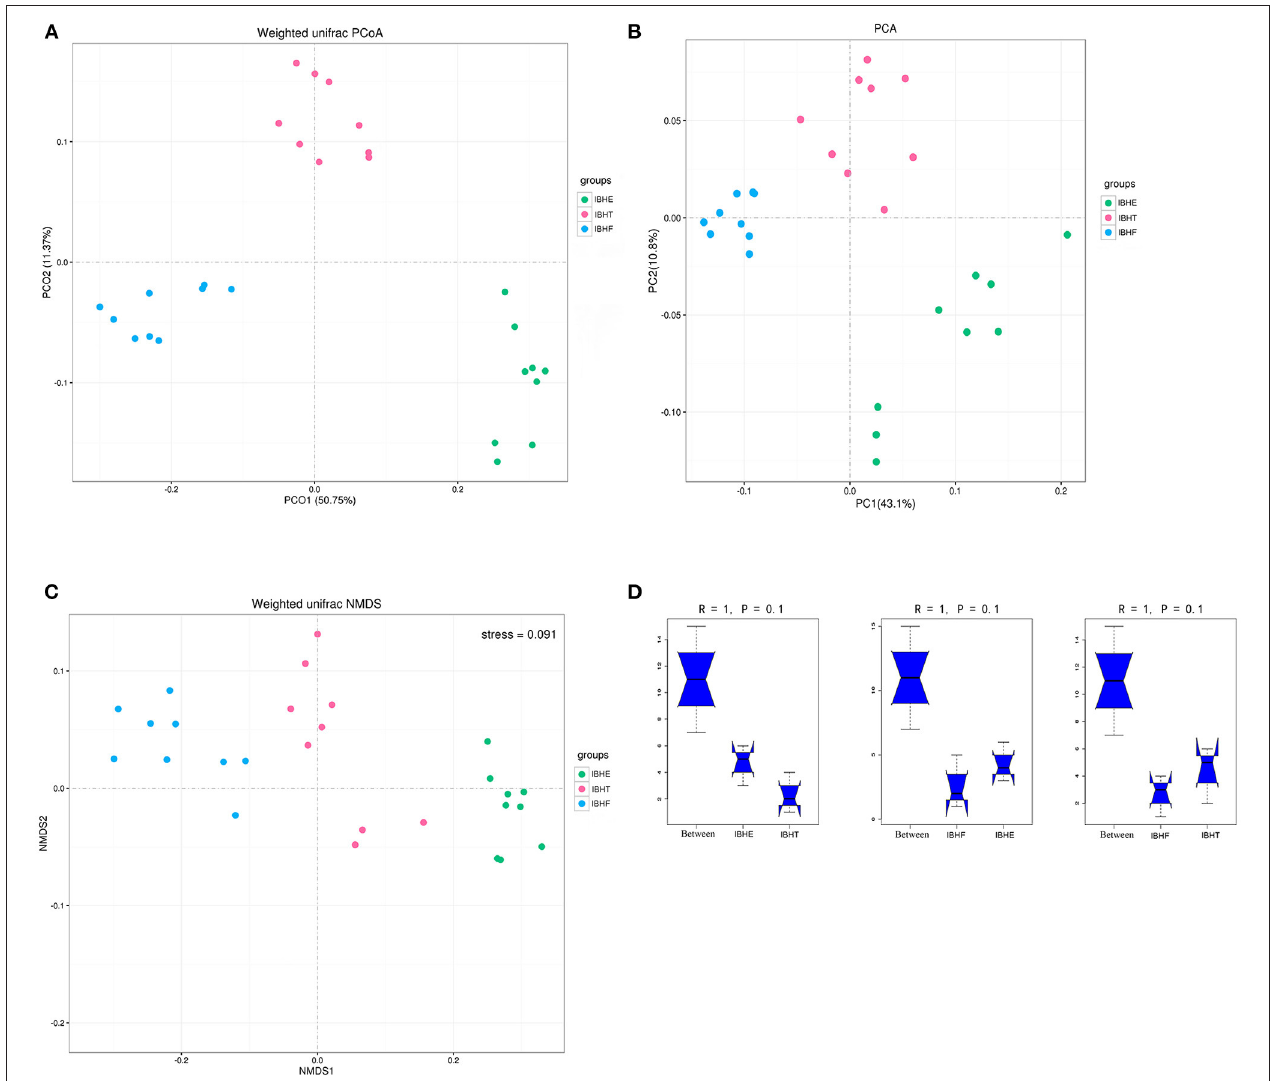
FIGURE 2 | β -Diversity analysis of samples at 8, 20, and 50 weeks. (A) Weighted uniFrac principal coordinates analysis (PCoA) of samples at 8, 20, and 50 weeks. IBHE, IBHT, and IBHF refer to “ISA Brown Hens-8 weeks,” “ISA Brown Hens-20 weeks,” and “ISA Brown Hens-50 weeks,” respectively. Dots of different colors represent samples in different growth periods. The closer the distance between the two points, the smaller the difference of community composition. The bottom right corner of the picture (green) was IBHE, the top right corner (pink) was IBHT, and the left corner (blue) was IBHF. (B) Weighted uniFrac principal component analysis (PCA) of samples at 8, 20, and 50 weeks. In PCoA and PCA plots, abscissa and ordinate represent the first and second principal component explaining the greatest proportion of variances in the communities, respectively. (C) non-metric multidimensional scaling (NMDS) of samples at 8, 20, and 50 weeks. The stress value is used to estimate the accuracy of the model. The closer the stress value approaches zero, the better the model effect is. The model with stress value < 0.1 can be accepted. (D) Anosim analysis of samples at 8, 20, and 50 weeks. The abscissa represents the comparison among all samples (between) and the comparison within each group, and the ordinate represents the distance between samples. The range of rank ( R ) is − 1 to 1. R > 0 indicates that the difference between groups was greater than that within groups. P -value > 0.05 indicates no statistical